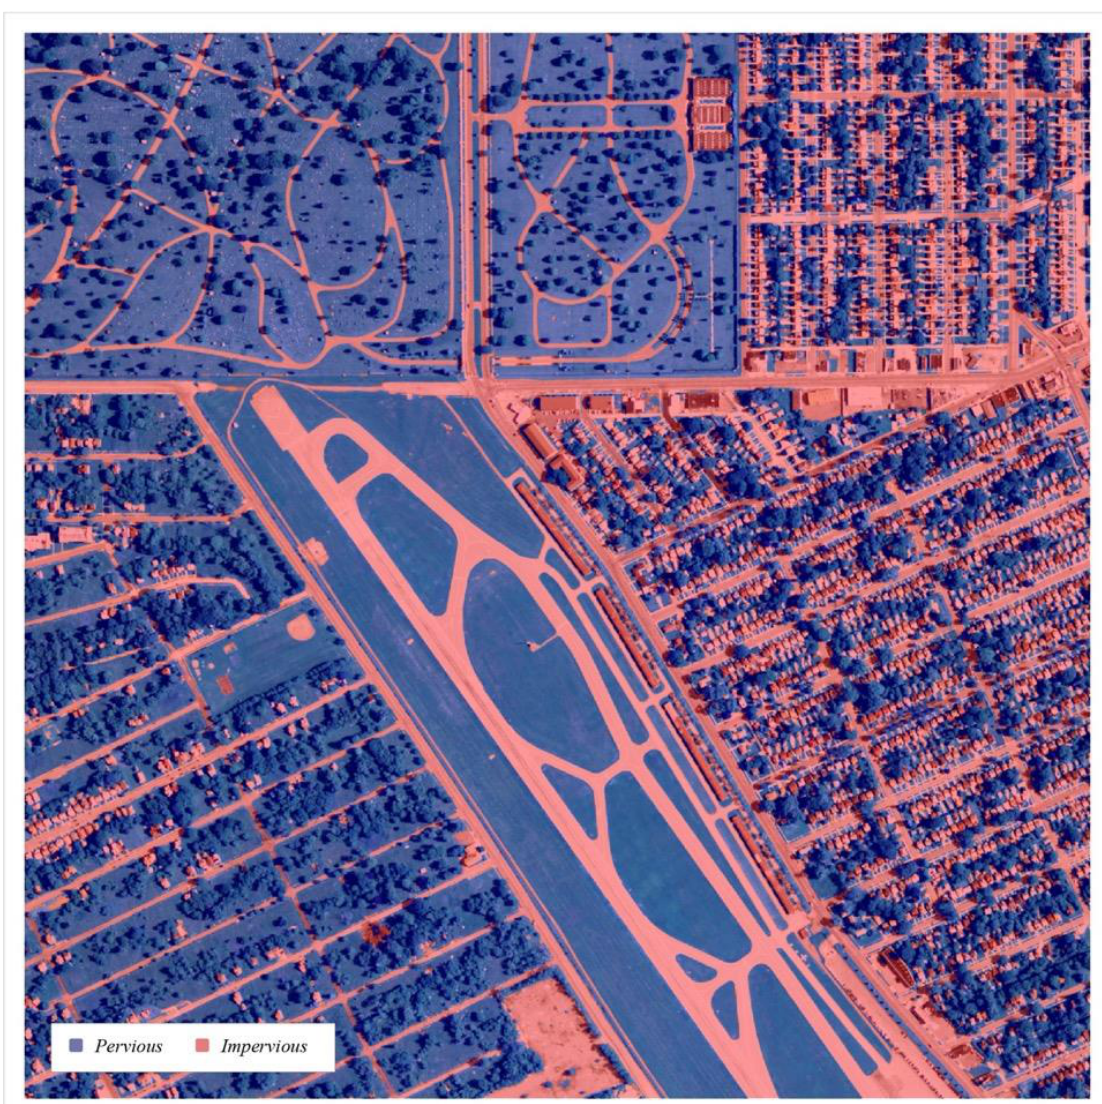
Figure 8. NAIP 2014 2.59 km 2 (one square mile) tile extent—classification result.